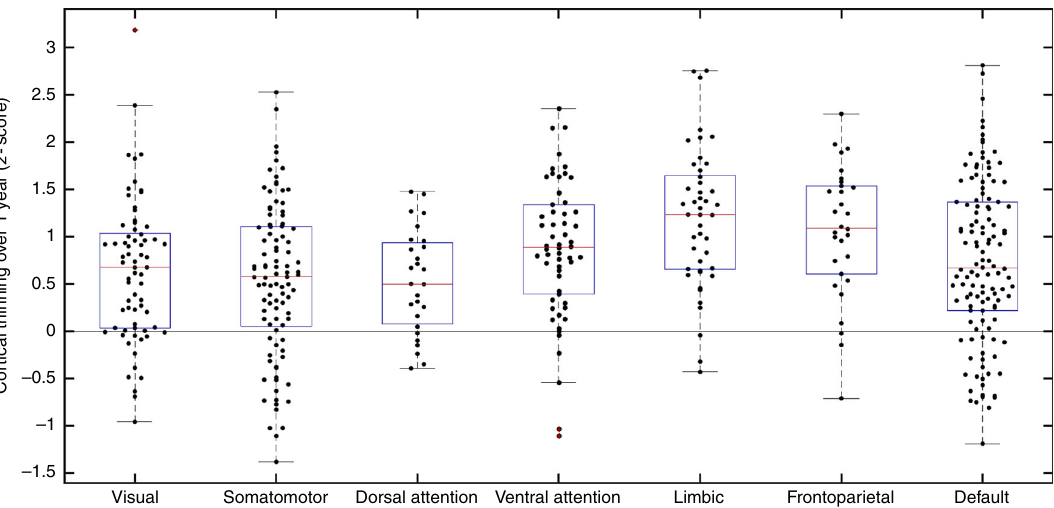
Fig. 3 Intrinsic networks affected by cortical thinning. Cortical thinning in PD vs HC in the seven intrinsic brain networks of Yeo et al. 27 . All seven intrinsic brain networks demonstrated signi fi cant cortical thinning with p < 0.0001 (permutation test n = 10,000): visual network ( μ ¼ 0 : 63 ; 95